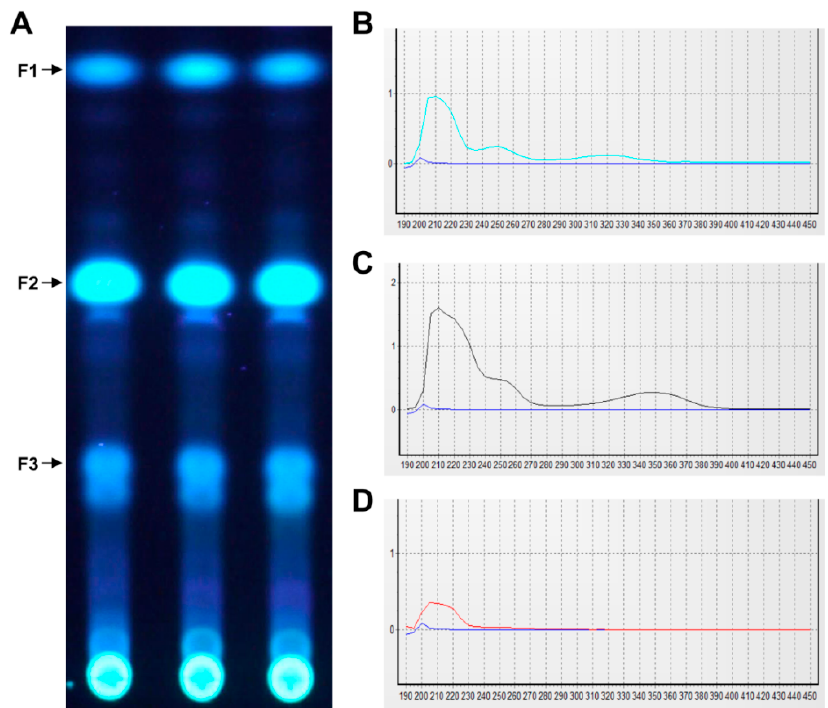
Figure 2. ( A ) TLC analysis of the main fractions of ELF000039 crude extract under UV light; ( B – D ) UV spectra of three main fractions (F1, F2, and F3). The blue line is the UV spectral baseline of the solvent.